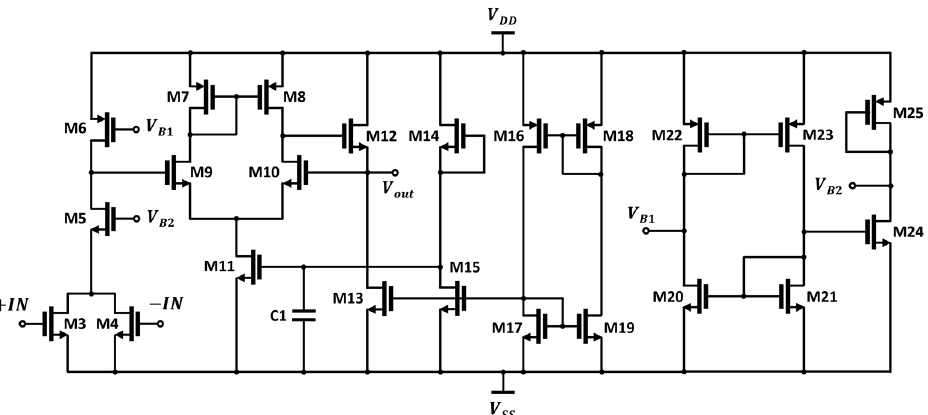
Figure 8. Schematic of the preamplifier and voltage buffer in the CMOS detector IC for the proposed detector array.